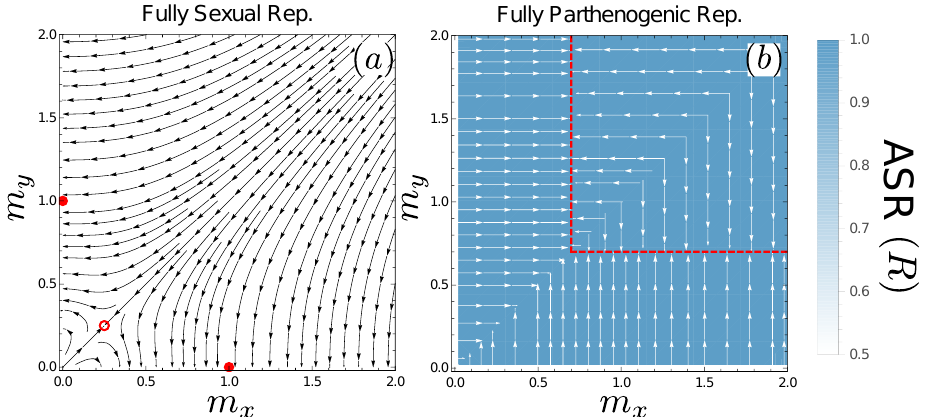
Figure 3. Evolutionary Dynamics under Fully Sexual or Fully Parthenogenic Reproduction. Arrows show the evolutionary trajectories in the limit | δ m | → 0 (see Equations (5) and (6) for panel ( a ) and Equation (7) for panel ( b )). Open red circles give unstable equilibrium points of the evolutionary dynamics, red disks stable equilibrium points, and dashed red lines stable manifold points. The colour (heatmap) indicates the ASR; the heatmaps do not show any responses to gamete sizes because ASR is always 0.5 under fully sexual reproduction and 1 under fully parthenogenetic reproduction. The heatmaps are uniform (and thus relatively uninteresting) but are given to enable direct comparison to later